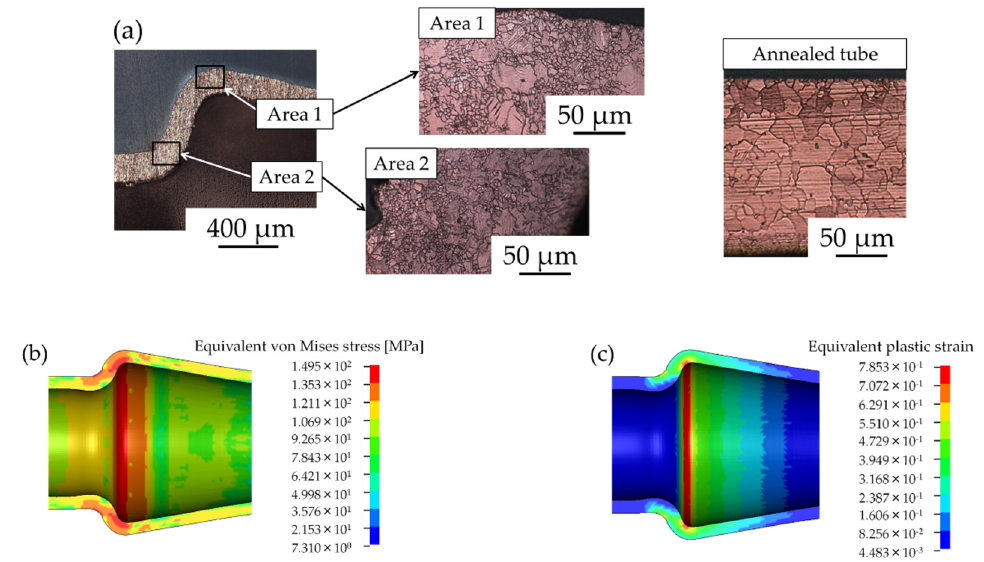
Figure 16. Microstructure at different positions of the taper-shaped tube and the FEM results of the taper-shape forming: ( a ) Microstructure of the taper-shaped tube; ( b ) distribution of the equivalent von-Mises stress at the taper; ( c ) distribution of the equivalent plastic strain.